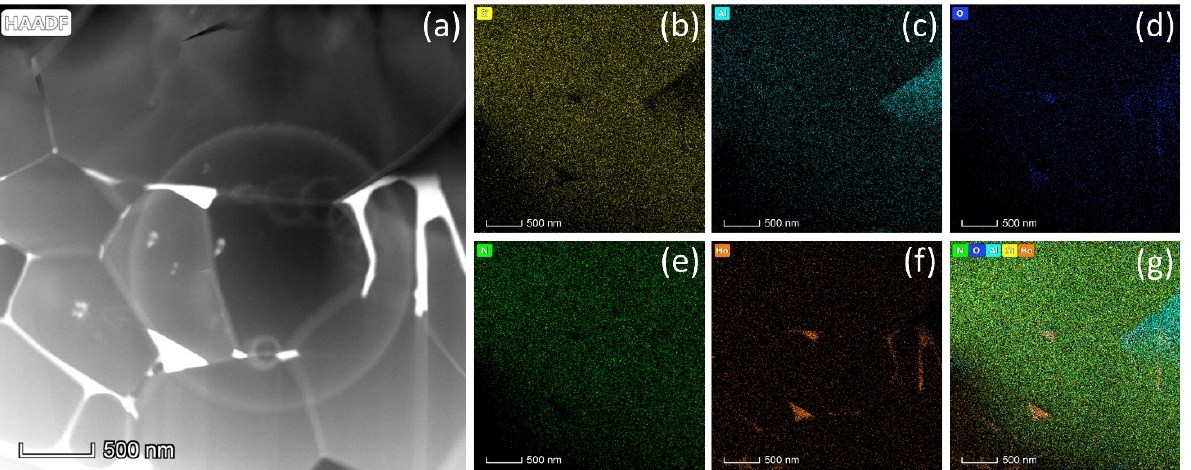
Figure 4. Elemental mapping diagram of H15 sample. ( a ) HAADF image. Images ( b – f ) correspond to the mapping spectra of Si, Al, O, N and Ho, respectively, of the region indicated in ( a ). ( g ) Superposition of the elemental spectra of ( b – f ).